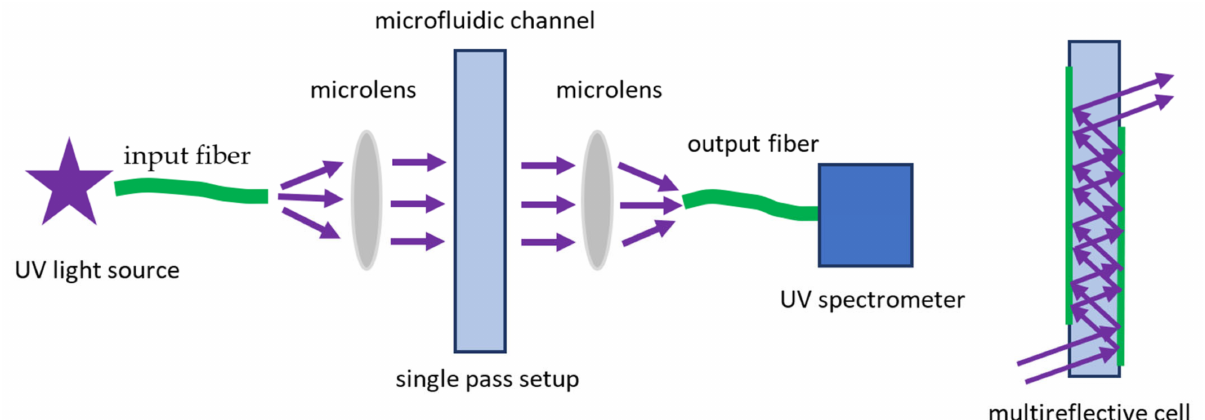
Figure 5. UV absorption detection in a microfluidic system (violet arrows—UV light